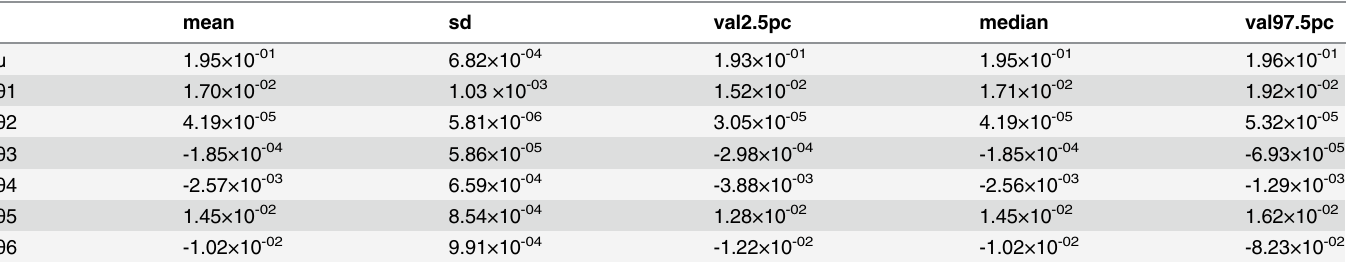
Table 3. Parameters inferred by the landscape Bayesian model with their respective posterior probabilities (mean, standard deviation, median, and 95% credible interval): μ (global mean), θ 1 (site effect), θ 2 (slope of the relation between geographical and genetic distance within sites accord- ing to a 2D x,y-plane), θ 3 (slope of the relation between the geographical and genetic distance within sites according to an elevation gradient), θ 4 (drought severity effect), θ 5 (waterlogging frequency effect), and θ 6 (soil type effect).